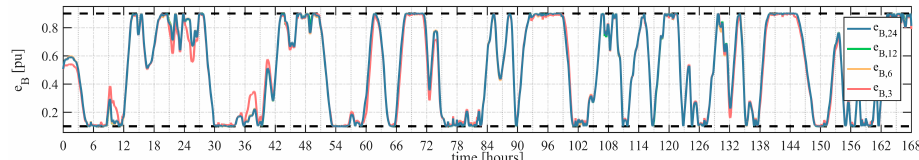
Figure 14. The B energy evolutions achieved by OPEM over a generic week by employing different time horizons.